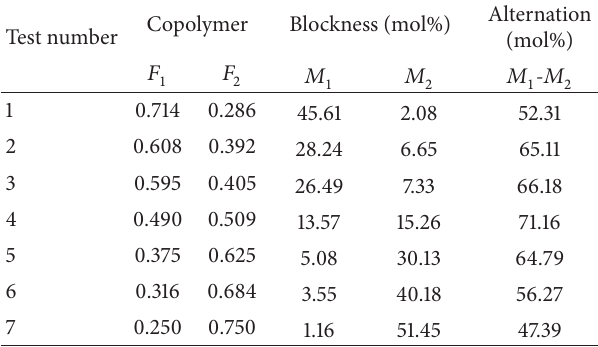
Figure 5: Mayo-Lewis plot of TMEVS/NVP copolymer.